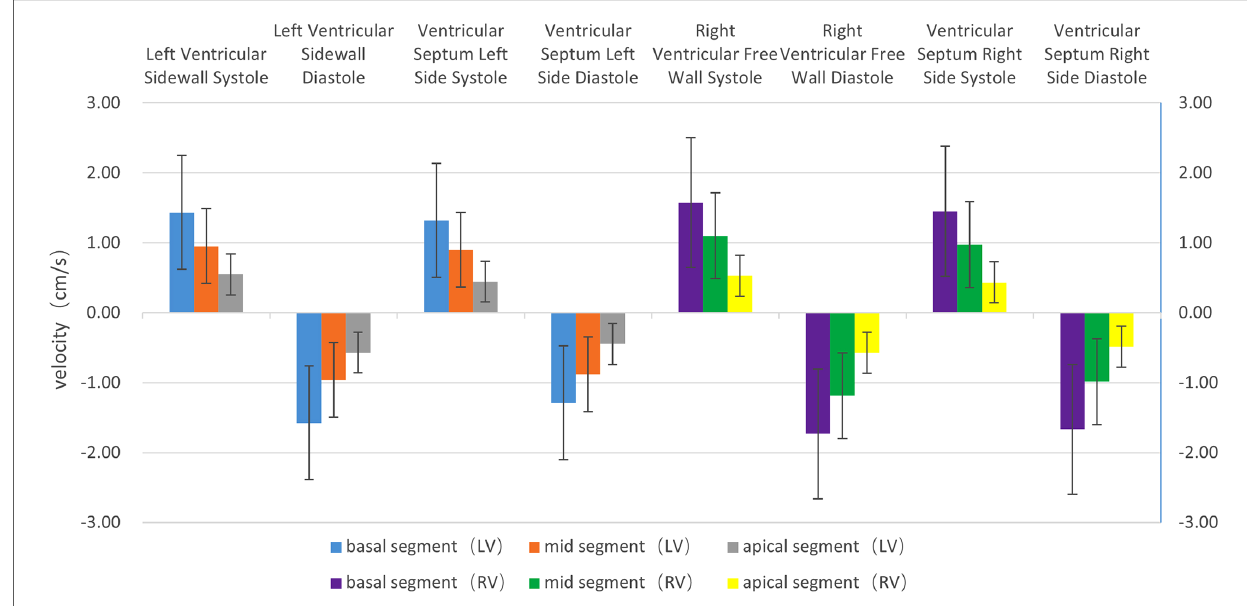
FIGURE 2 The histogram of the systolic and diastolic velocities of the left and right ventricular longitudinal walls at each segment. The velocities of the left and right ventricles, regardless of lateral wall (free wall) or interventricular septum, show a decreasing trend from the basal segment to the apex segment, in the following order: basal segment>middle segment>apex segment. The differences are statistically signi fi cant ( P <0.05). The systolic velocity is a positive value, and the diastolic velocity is a negative